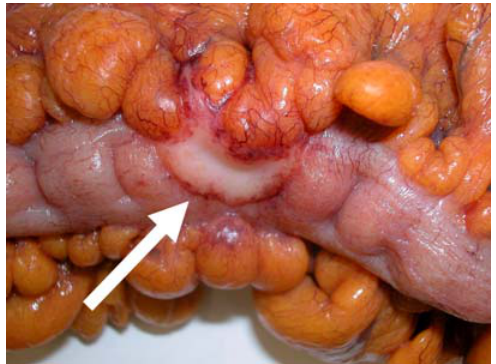
Figure 4. Macroscopic image of colon carcinoma with serosal involvement. Note the thickened central plaque of the tumor involving the serosa on the anti-mesenteric border (arrow) in comparison with the normal shiny serosal surface on either